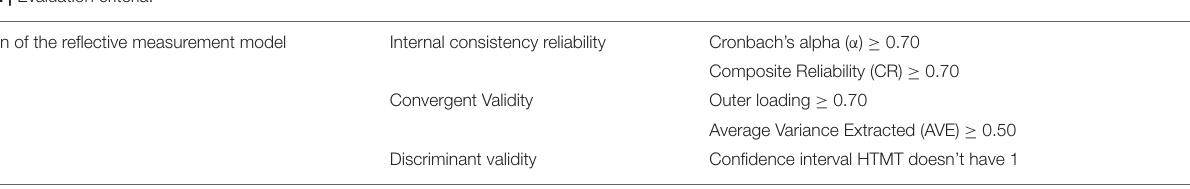
TABLE 2 | Evaluation criteria. Evaluation of the reflective measurement